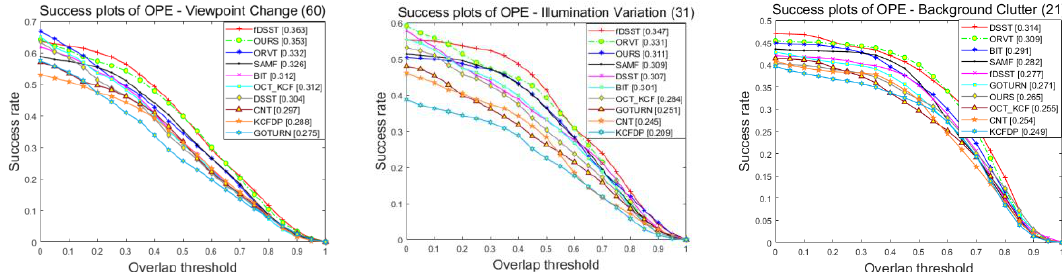
Figure 6. Success plots of our tracker compared with state-of-the-art approaches on UAV123 dataset.